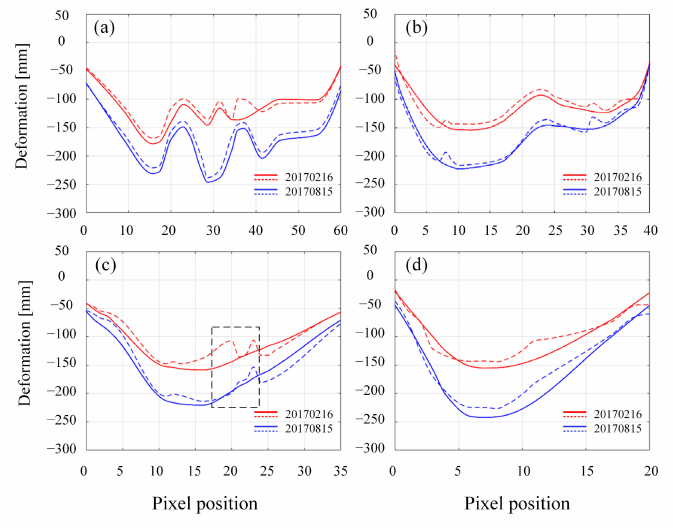
Figure 19. Profile analysis based on SBAS (dotted line) and CT-PIM (solid line) predicted subsidence: ( a ) Profile EE’; ( b ) FF’; ( c ) GG’; ( d ) HH’.